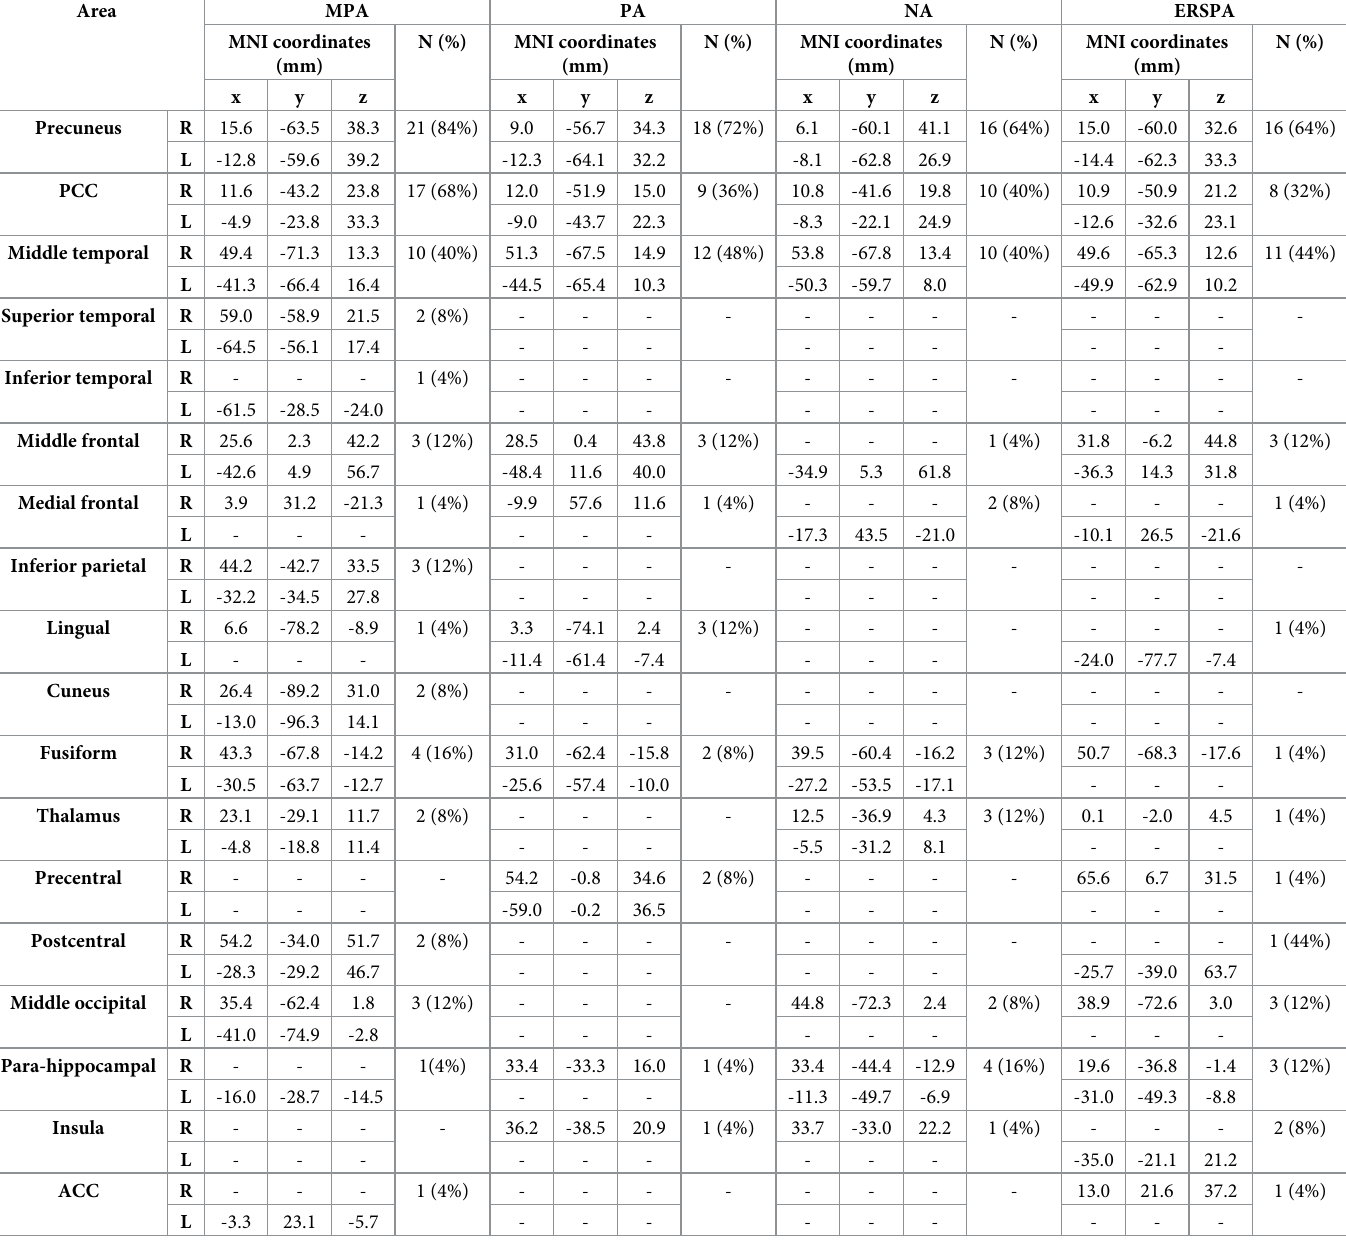
Table 2. Coordinates of training-induced alpha sources for the four averaging